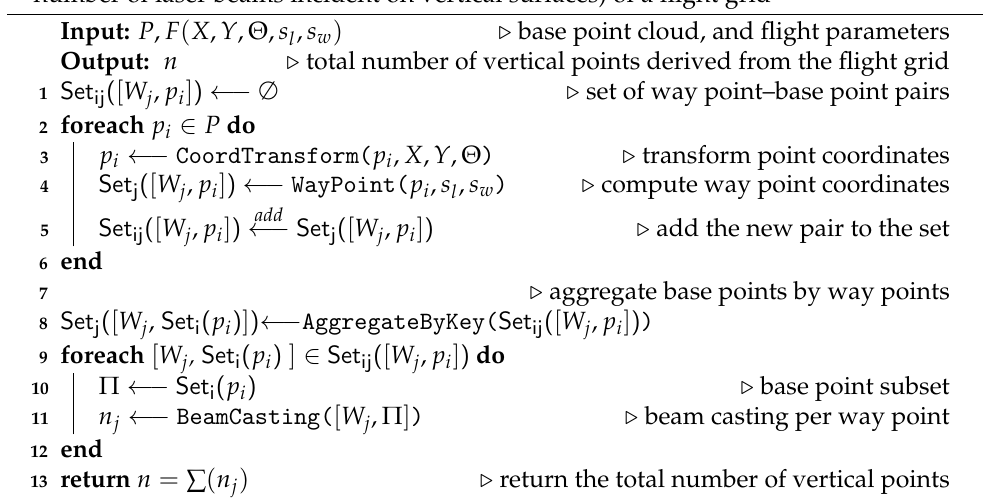
Algorithm 3 computes the fitness score, n , of a candidate flight grid using the